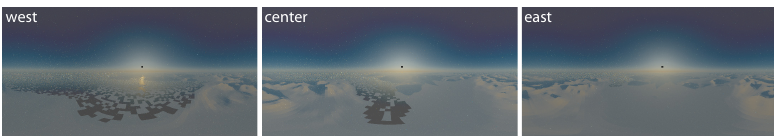
Figure 5. Simulated 360 ◦ views (RGB radiances) for the standard scenario from 2.5km above each station, zenith to nadir. The sun is in the north (black dot). The views nicely illustrate the different albedo environment at each station (increasing albedo from west to east) and the sun glint at station